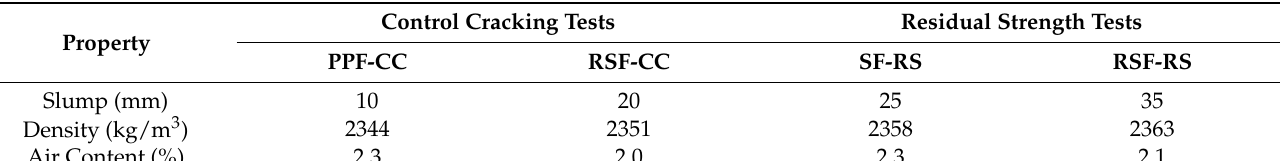
Table 3. Fresh state properties of the concrete mixes.